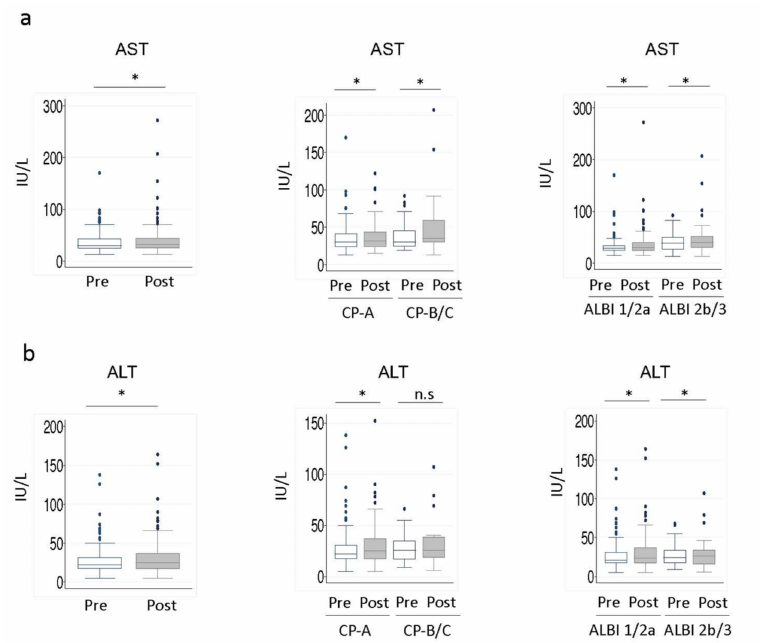
Figure 3. Changes in serum AST (( a ), n = 125) and ALT (( b ), n = 125) levels after vaccination in patients with cirrhosis. All patients are shown in the left panel, CP class A (n = 91) and B/C (n = 20) are shown in the middle panel, and ALBI grade 1/2a (n = 82) and 2b/3 (n = 42) are shown in the right panel. *: p < 0.05, n.s.: not significant.